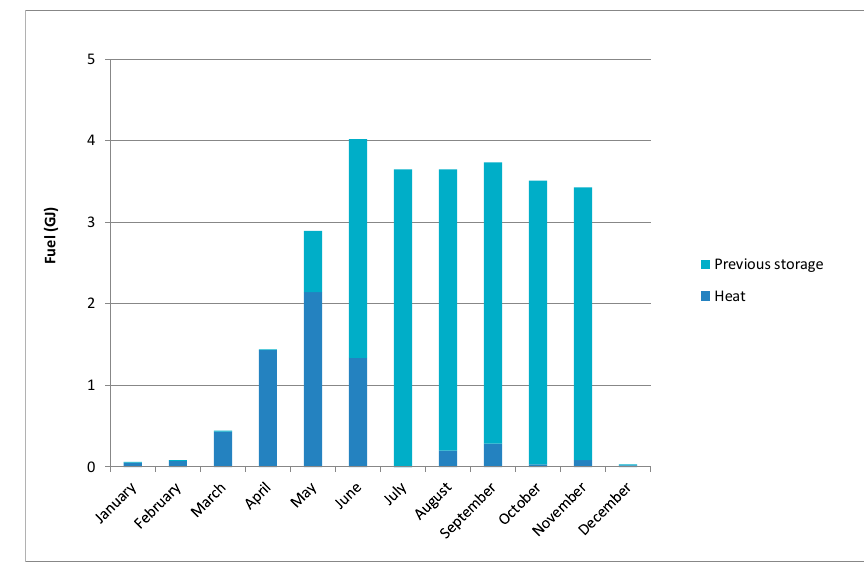
Figure 9. Seasonal storage: Fuel.